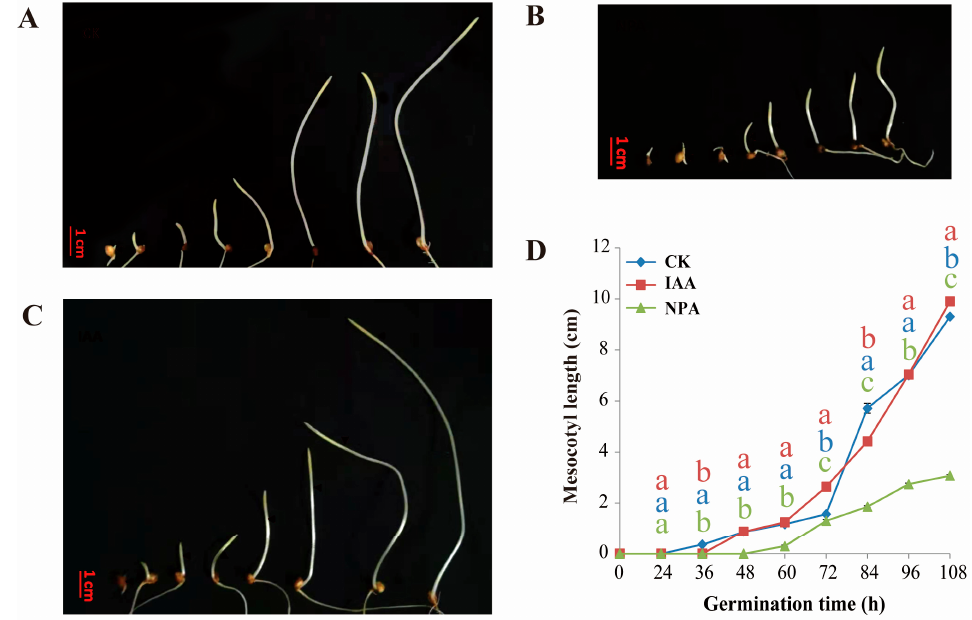
Figure 2. Mesocotyl length at different germination time in line Z210. ( A ) Mesocotyl morphology phenotype at 24 h, 36 h, 48 h, 60 h, 72 h, 84 h, 96 h, and 108 h of line Z210; ( B ) Mesocotyl morphology phenotype at each timepoint of line Z210 with exogenous IAA and NPA application; ( C ) Mesocotyl morphology phenotype at each timepoint of line Z210 with exogenous IAA application; ( D ) Line graph of mesocotyl length of three treatments at each timepoint of Z210. Lowercase letters indicate statistical differences ( p ≤ 0.05) among